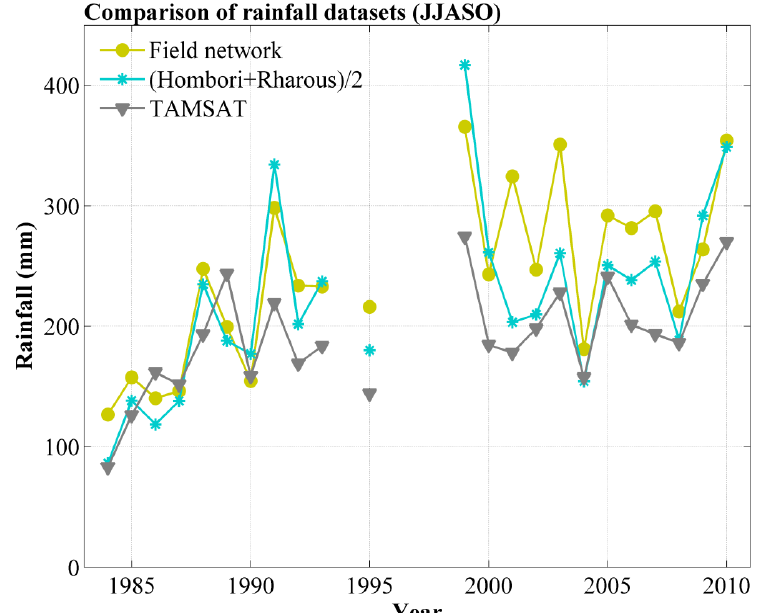
Figure A1. Comparison of various rainfall datasets: field network (average of rain gauges co-located to each vegetation site), average of the Hombori and Rharous rain gauges, and the TAMSAT gridded satellite product. All three products are averaged over the growing season (JJASO period).